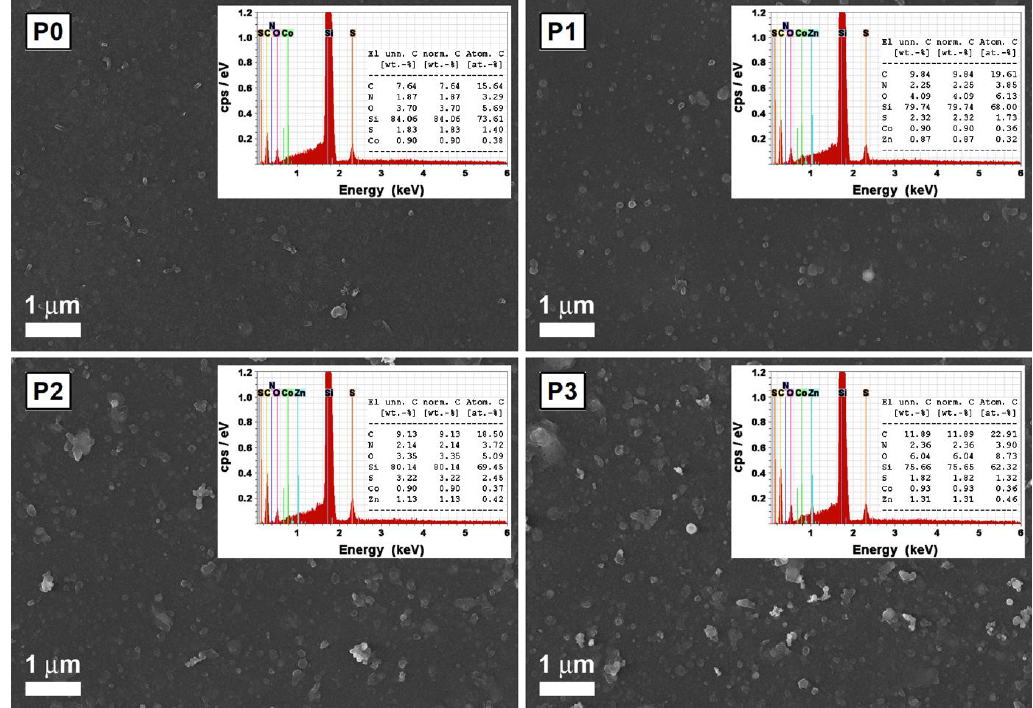
Figure 4. FESEM images of the MAPLE-deposited thin films. Insets: energy-dispersive X-ray analysis (EDX) spectra and weight and atomic percentages of the elements in the corresponding samples.